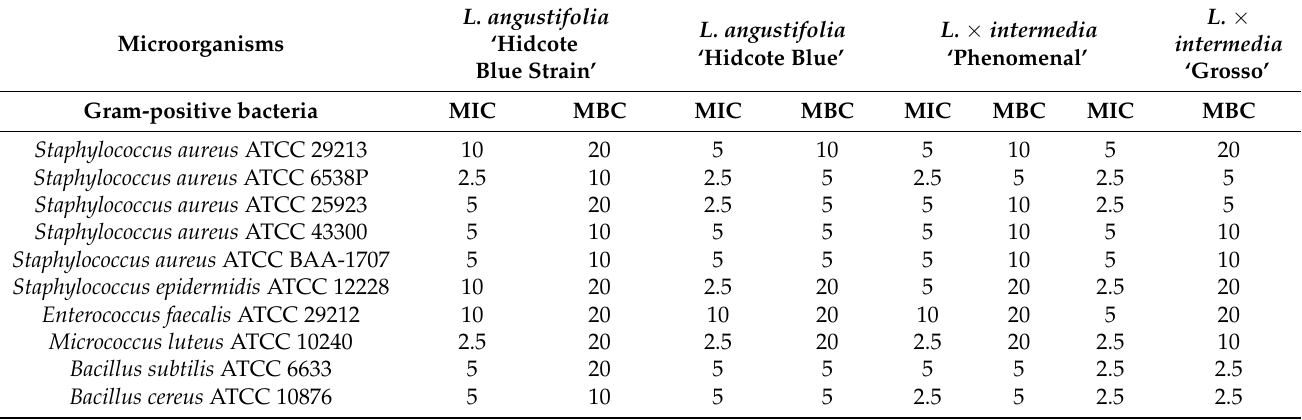
Table 3. MIC [mg/mL], MBC [mg/mL], and MFC [mg/mL] values of L. angustifolia ‘Hidcote Blue Strain’, ‘Hidcote Blue’, L. × intermedia ‘Grosso’ and ‘Phenomenal’ essential oils against reference strains of